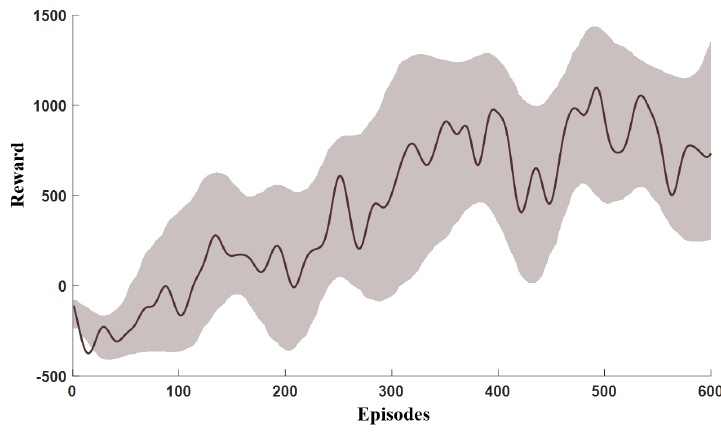
Figure 8. Learning curve—scenario